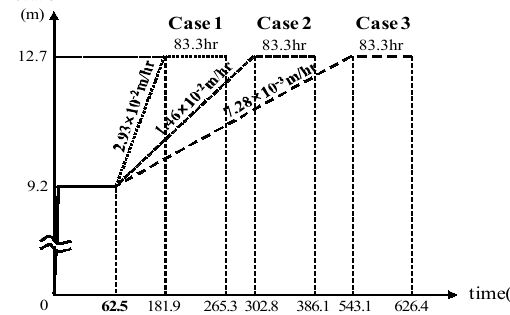
Fig. 4. Water-level-raising procedure for each